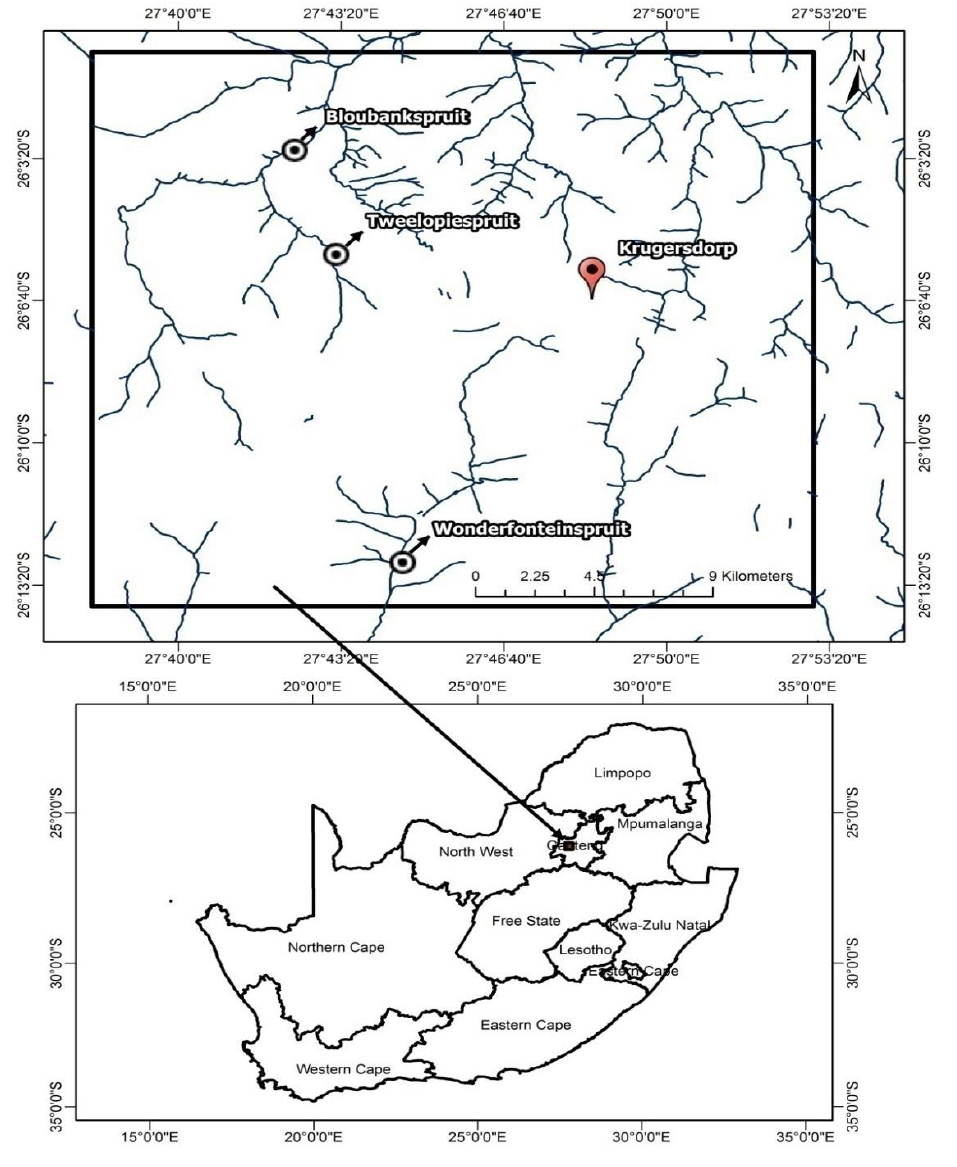
Figure 1. The study area.